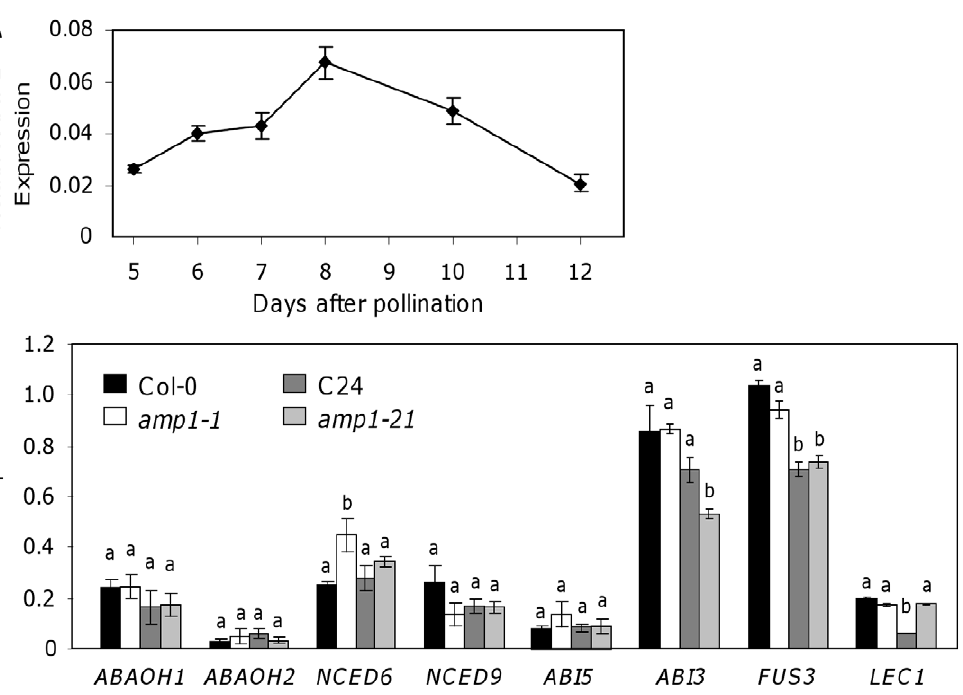
Figure 4. mRNA expression of AMP1 and other genes involved in dormancy acquisition. (A) AMP1 mRNA expression during seed development in Col-0. Under our experimental conditions seeds were considered mature at 14–15 days after pollination (B) Expression of several ABA-related genes and of AFL group of genes in Col-0, amp1-1 , C24 and amp1-21 developing seeds at 10 days after pollination. Means of three biological replicates with their SE are shown. Letters above bars identify statistically significant different values for each gene in a Student’s t-test (P , 0.05; n =3).